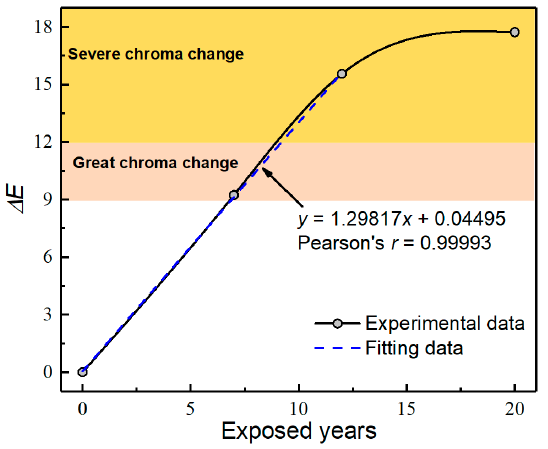
Figure 5. Off-color rate of epoxy primer-coated specimens subjected to different durations of exposure. Table 3. Measurement of contact angles of epoxy primer-coated specimens with different durations of exposure. (Unit: ◦